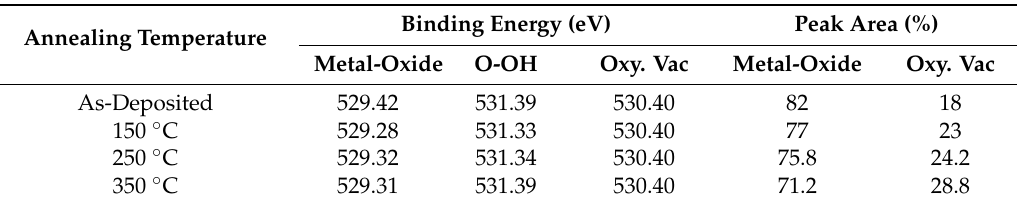
Table 3. Relative peak area ratio and binding energy of the IZTO thin films deposited by RF magnetron sputtering on silicon substrates at various annealing temperatures in the range of 150–350 ◦ C.